Question: According to this chart, does the measure grow or shrink?
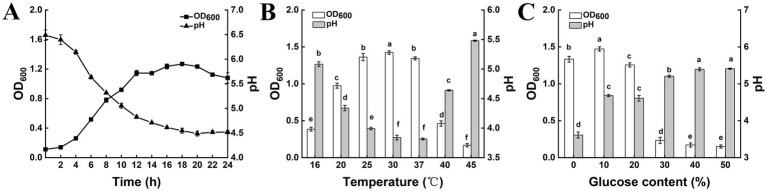
Answer: increasing